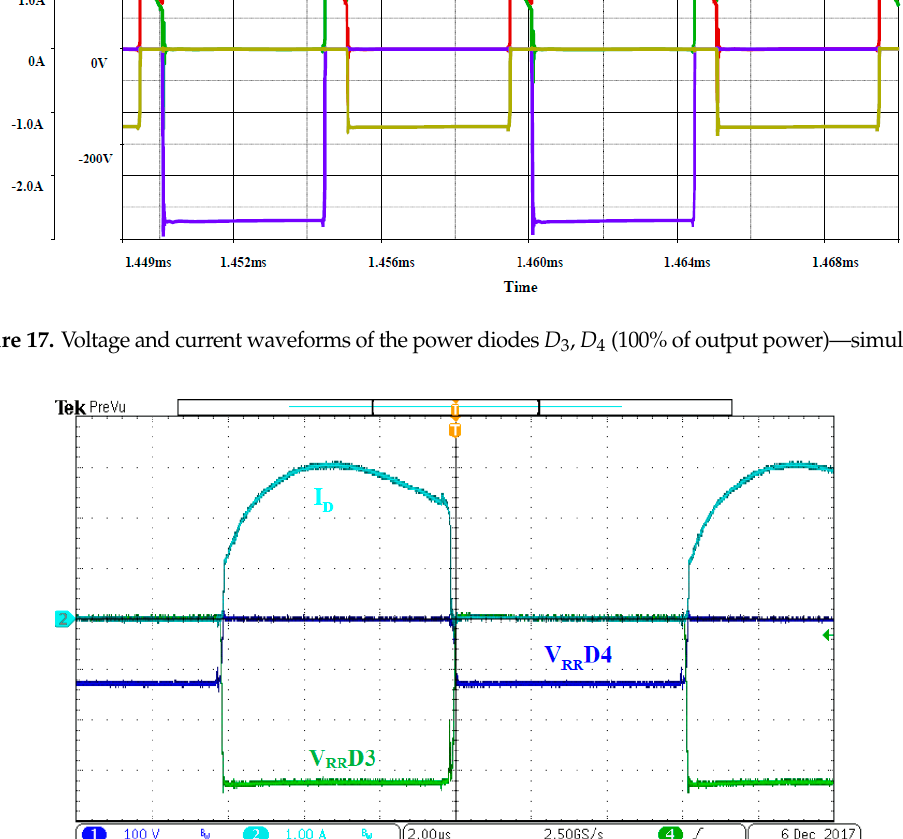
Figure 18. Voltage and current waveforms of the power diodes D 3 , D 4 (100% of output